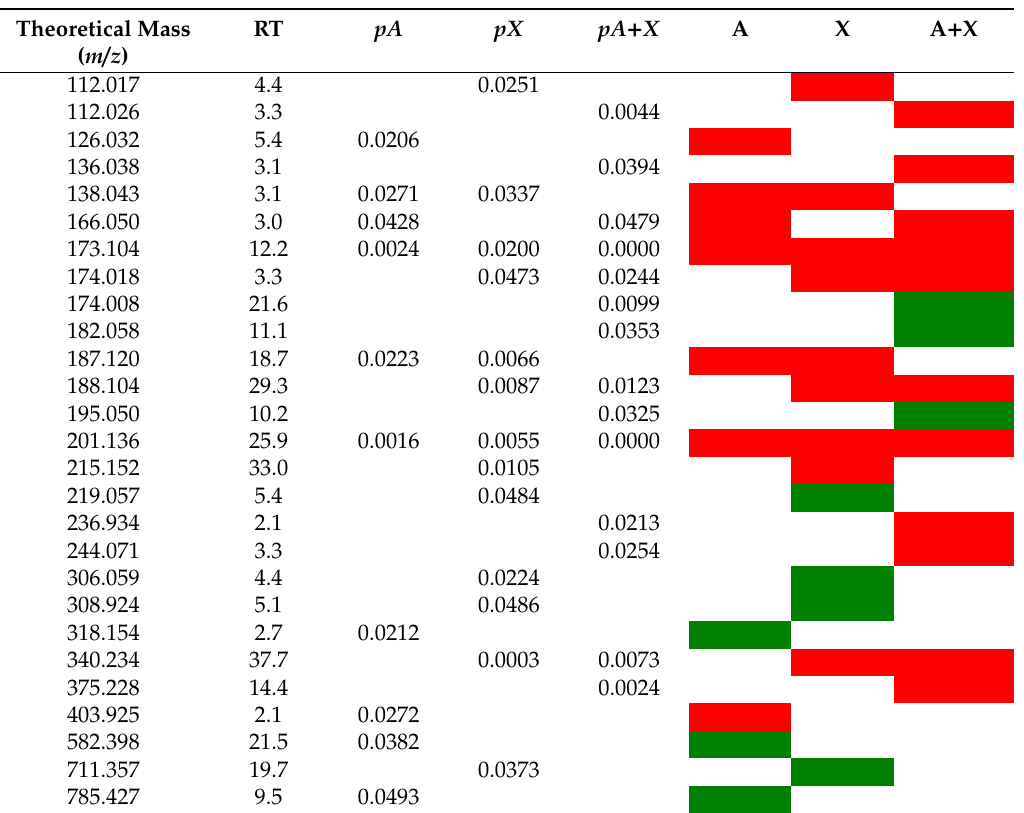
Table 4. Ions regulated from baseline to 8-months intervention in the three